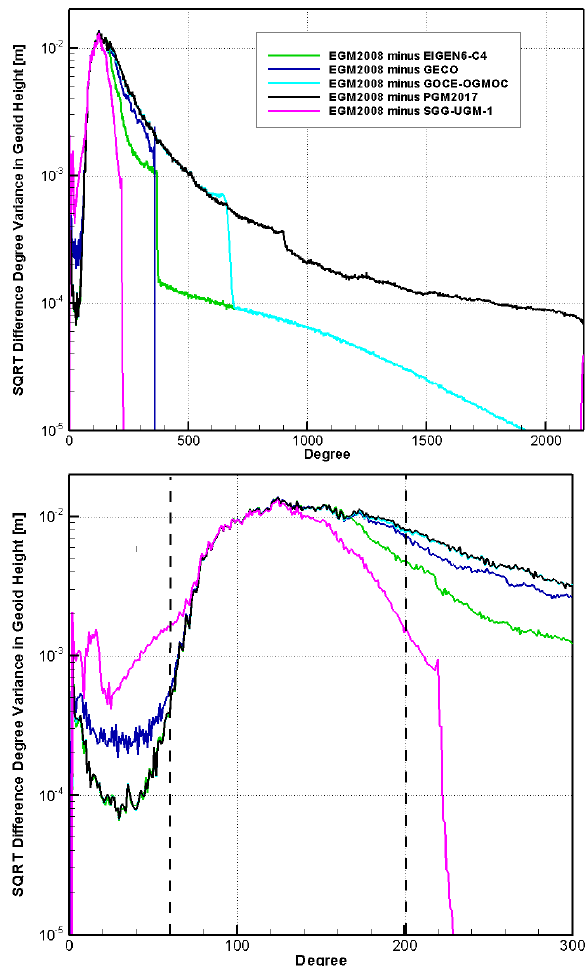
Fig. 1. Geoid height differences in terms of square root of difference signal degree variances between EGM2008 and high resolution gravity field models. Top: for the full resolution up to degree 2190; Bottom: Zoom in up to degree 300 (dashed lines mark the degrees 60 and 200).